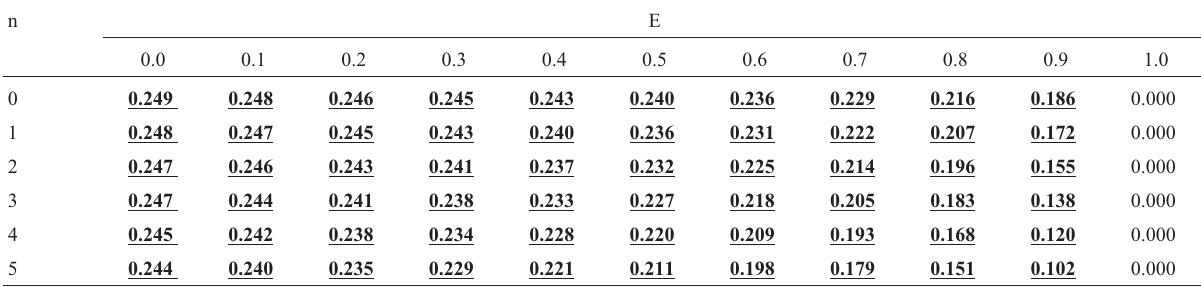
Table 2 - Recurrence risks for a sib of an isolated case, with consanguineous parents and F = 1/4 (full sibs, parent-child), in function of the rate of environmental cases (E) and of the number of normal sibs (n = n m + n f ) that the affected child already has. n E 0.0